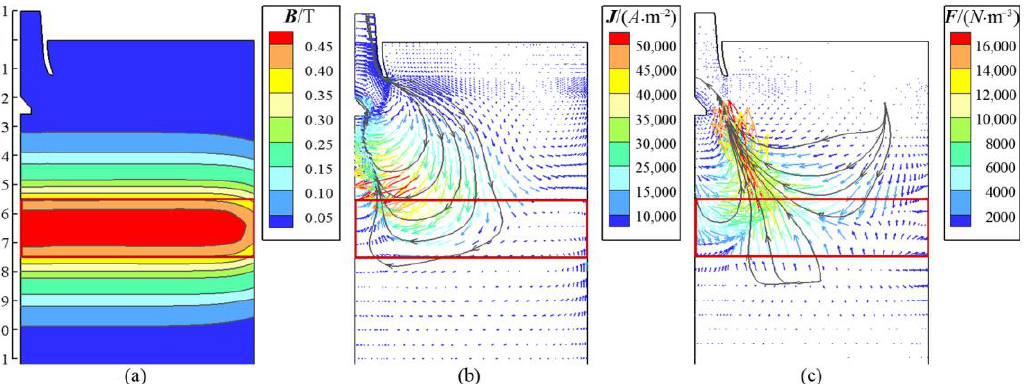
Figure 10. Electromagnetic characteristics in the central plane of the CSP mold: ( a ) magnetic flux density, ( b ) induced current density, and ( c ) electromagnetic force.